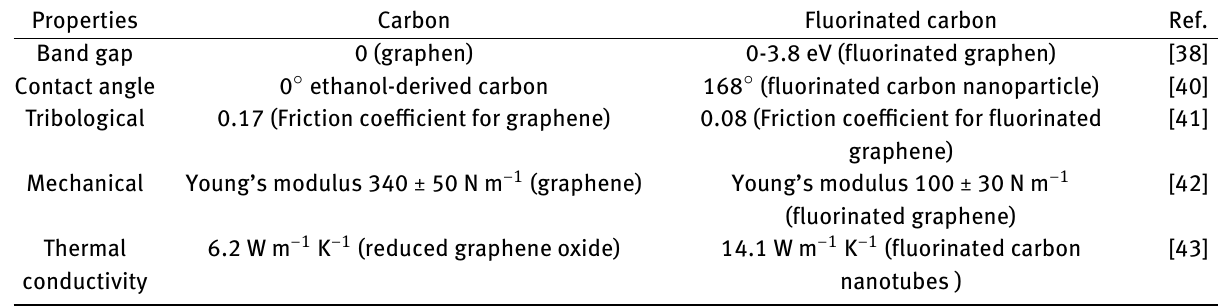
Table 2: Comparing the properties of fluorinated carbon and carbon materials in different applications Properties Carbon Fluorinated carbon